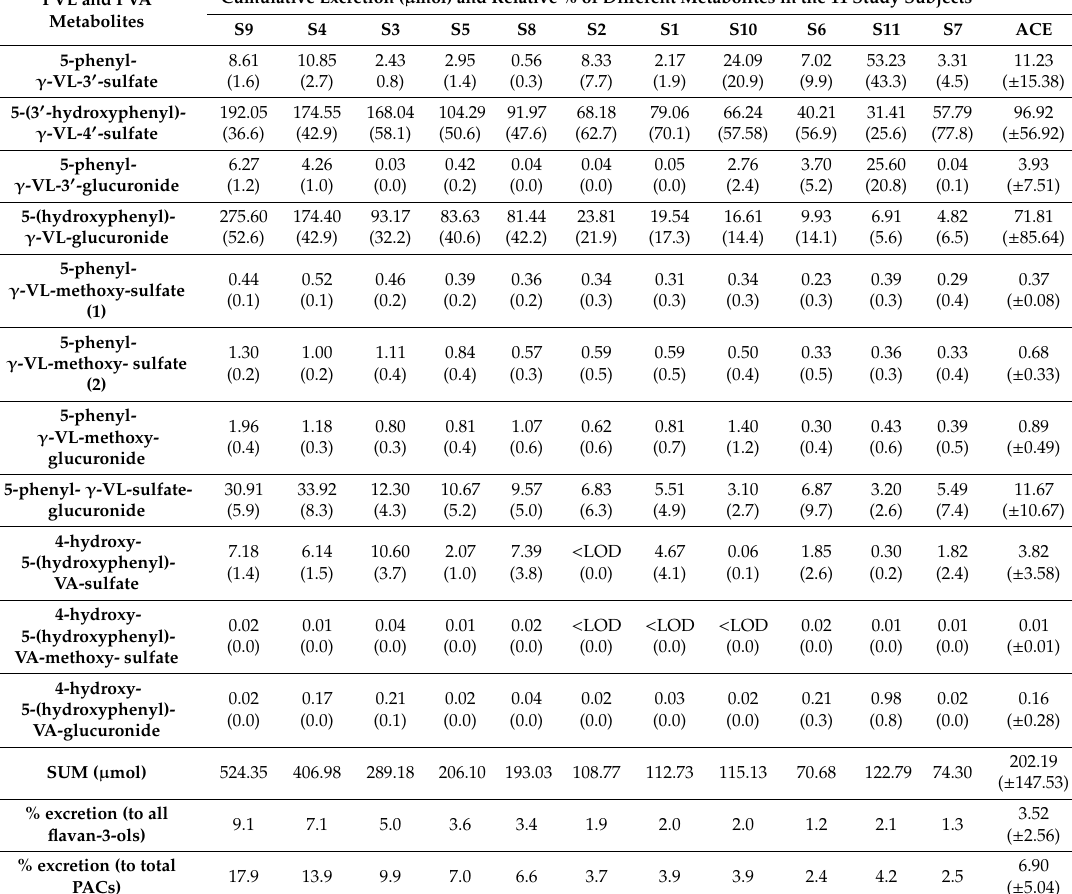
Table 3. Urine cumulative excretion of phenyl- γ -valerolactones and phenylvaleric acids ( µ mol) in the interval T1–T24 in 11 subjects (S1–11). The values reported in brackets indicate the percentage of each metabolite on the sum of all detected compounds. ACE: average cumulative excretion ( ± standard